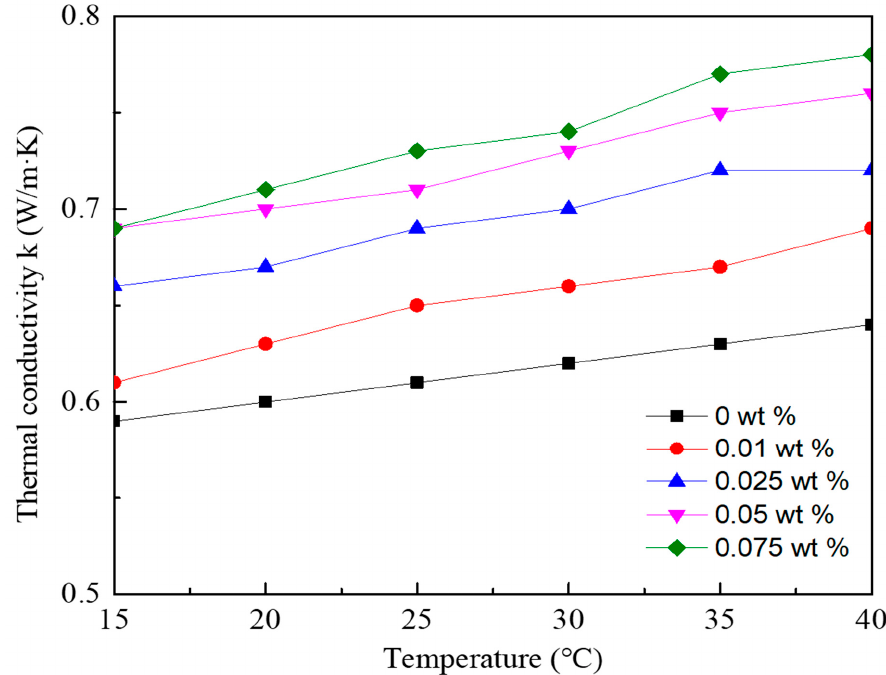
Figure 3. Thermal conductivity of graphene/water nanofluid with various GNPs concentrations at different